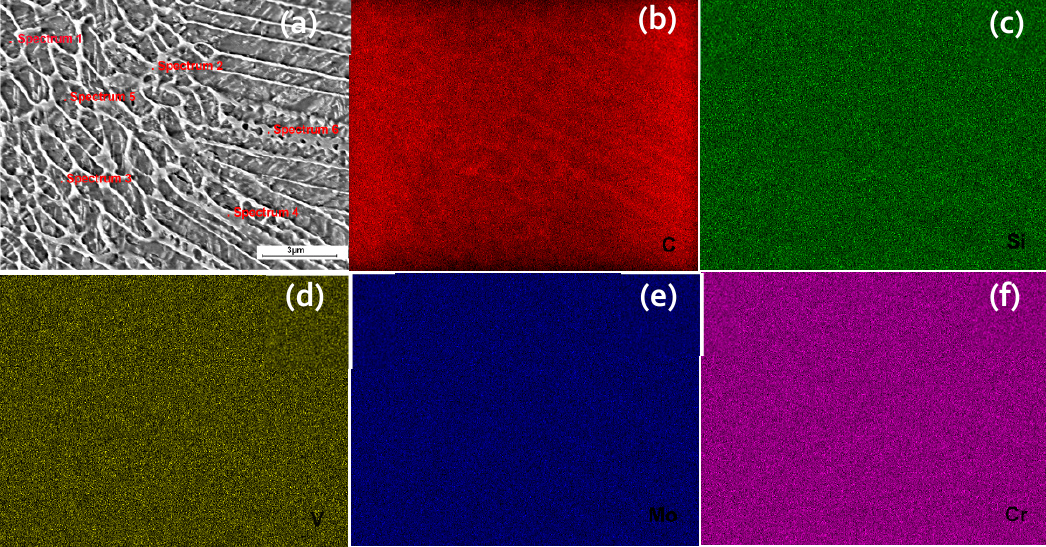
Figure 13. Energy-dispersive X-ray spectroscopy (EDS) maps of the formed morphologies along the build direction: ( a ) Location of points; ( b ) C element; ( c ) Si element; ( d ) V element; ( e ) Mo element; and ( f ) Cr element.